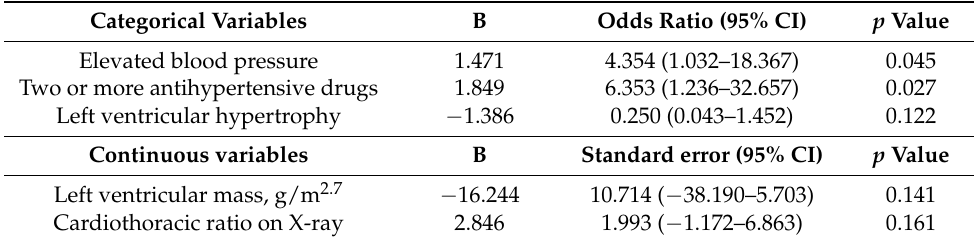
Table 2. Differences in clinical parameters after adjusting by the duration of